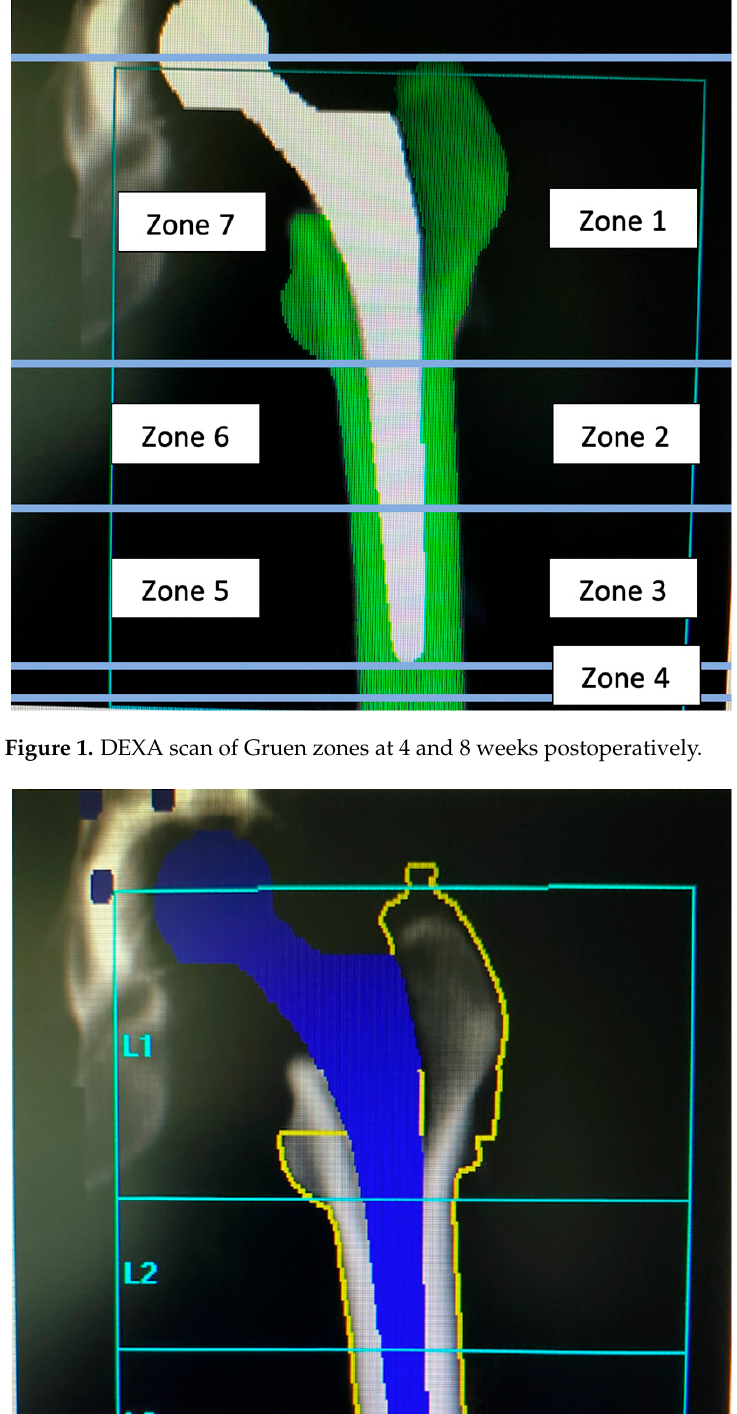
Figure 1. DEXA scan of Gruen zones at 4 and 8 weeks postoperatively.